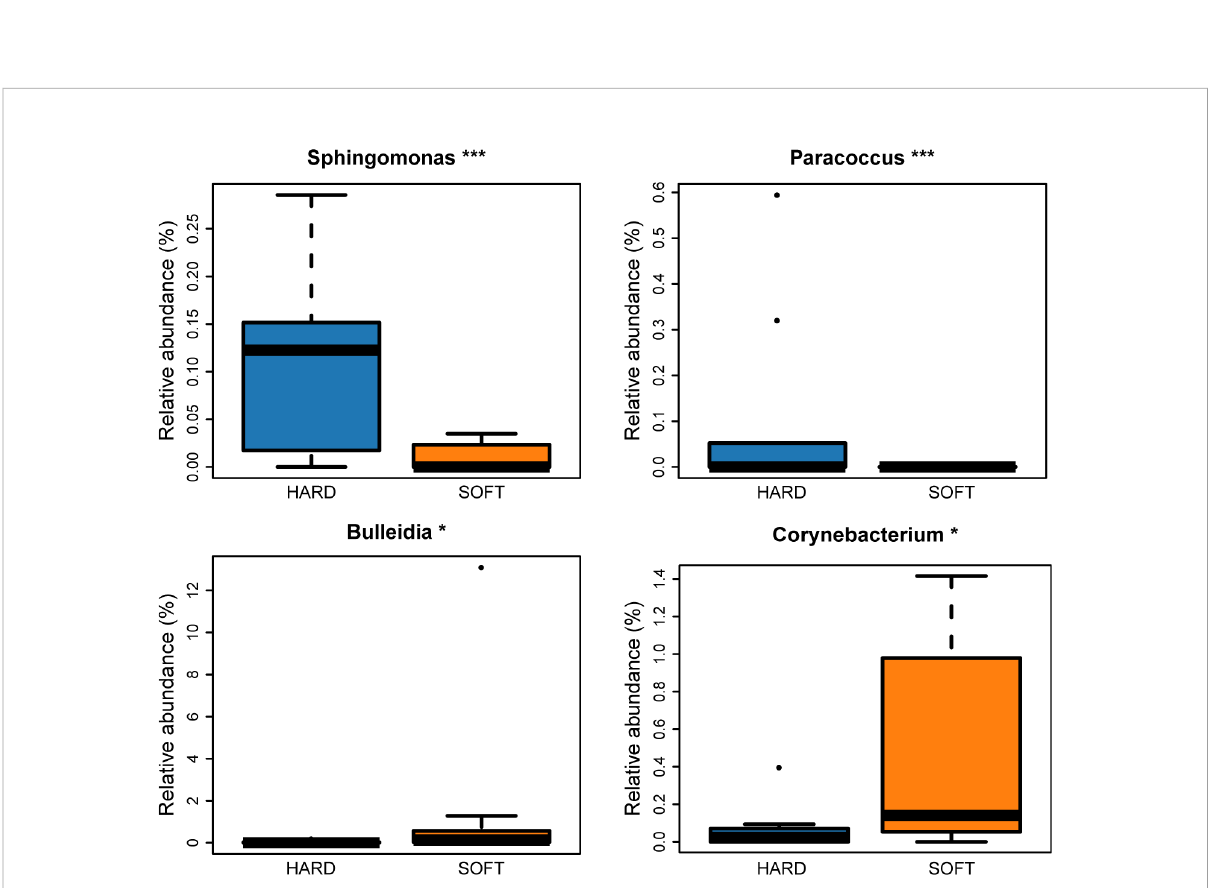
FIGURE 2 Microorganisms with signi fi cant difference between HARD and SOFT samples at the genus level. (*p < 0.05; ***p < 0.001).